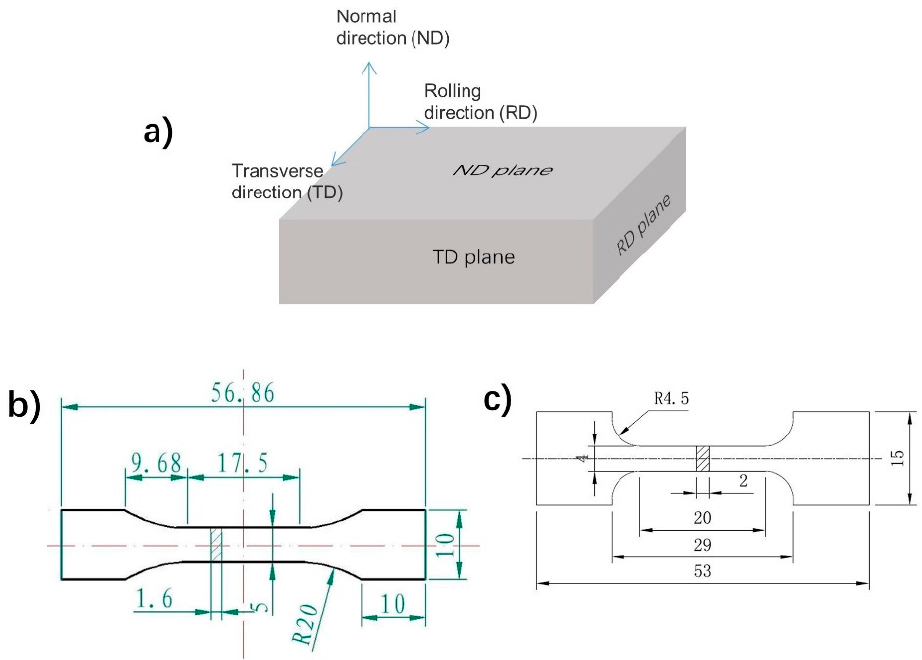
Figure 1. Schematic geometries of ( a ) the as-received heat-rolled MA21 alloy plates, ( b ) the specimens for room temperature tensile tests and ( c ) the specimens for tensile tests at elevated tempera- tures.